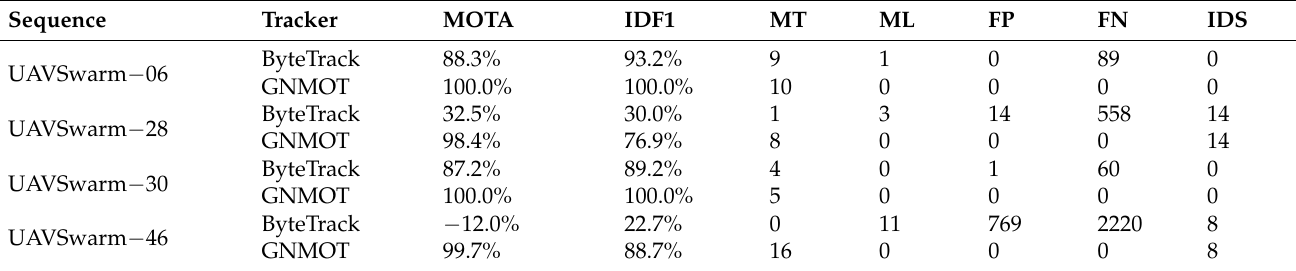
Table 7. Partial UAVSwarm dataset testing sequence tracking